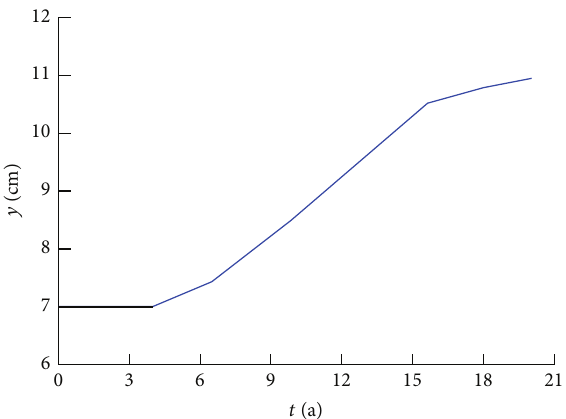
Figure 4: Curve of development of maximum deflection of pile foundation under normal operation condition.